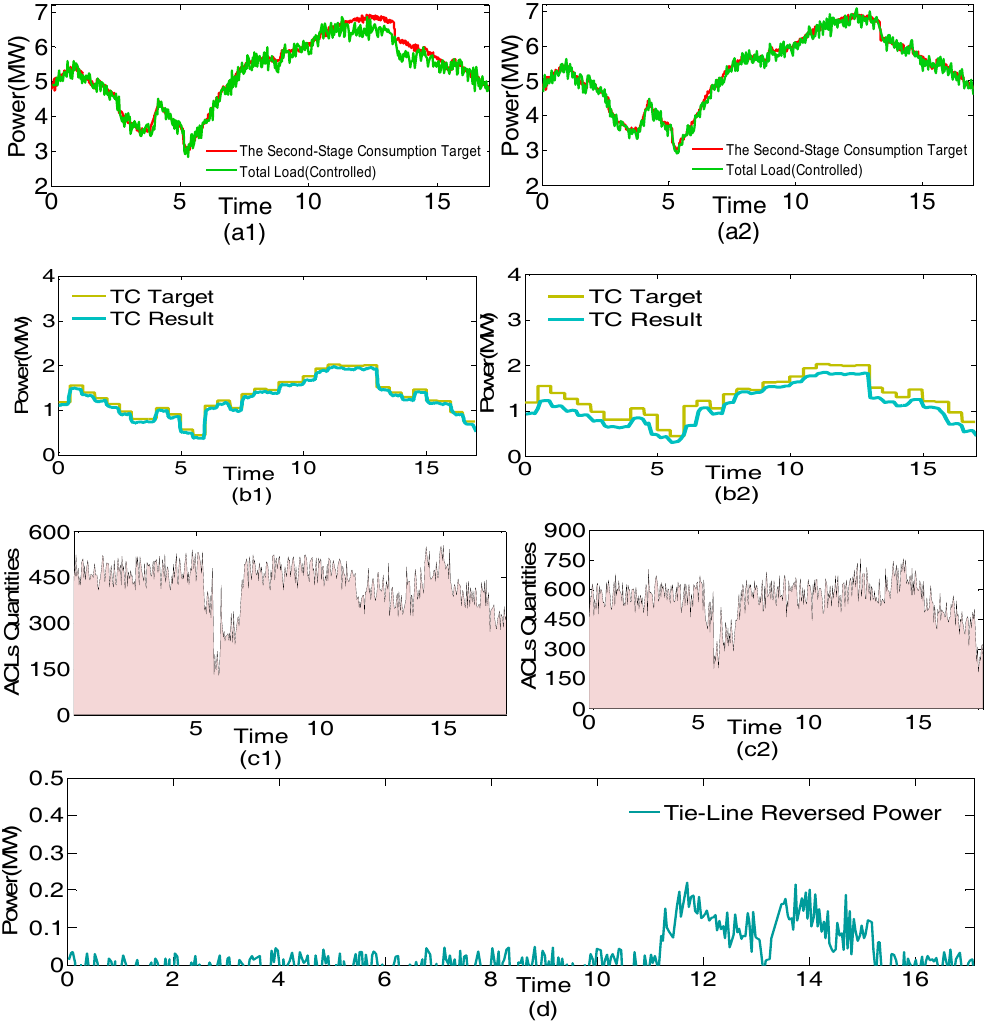
Figure 12. Consumption results ( a1 , a2 ) the second-stage consumption result at 28 °C and at 33 °C; ( b1 , b2 ) the TC result at 28 °C and at 33 °C; ( c1 , c2 ) the quantities of ACLs for SC at 28 °C and at 33 °C; and ( d ) the Tie-line reversed power at 28 °C.